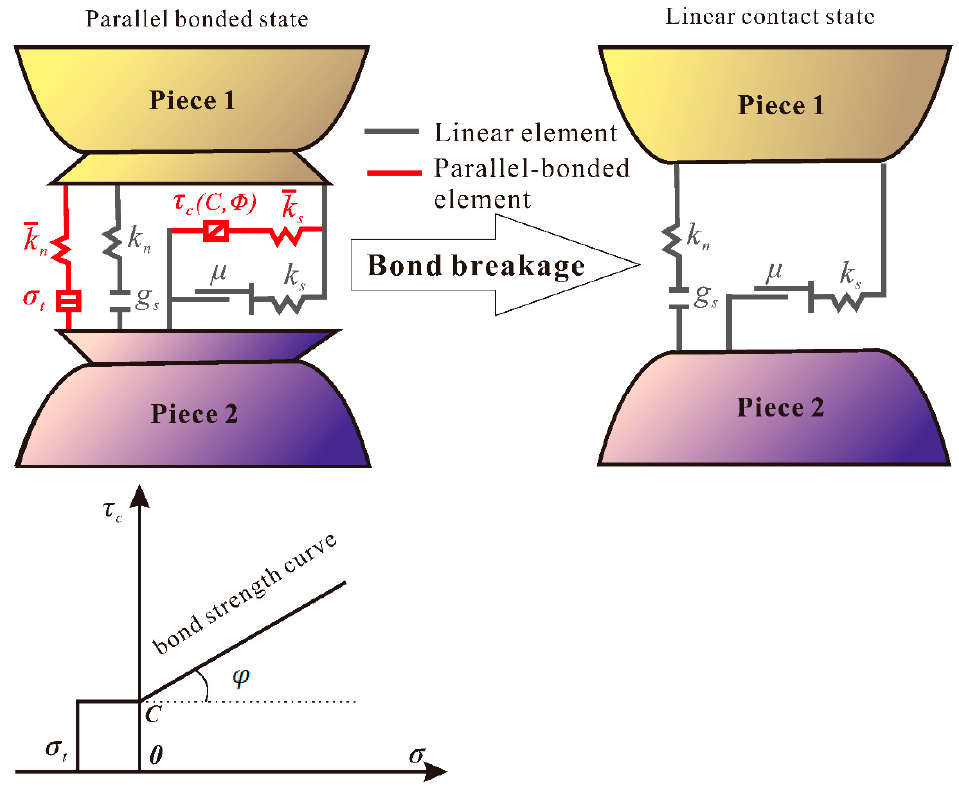
Figure 16. Difference between PBM and linear model.